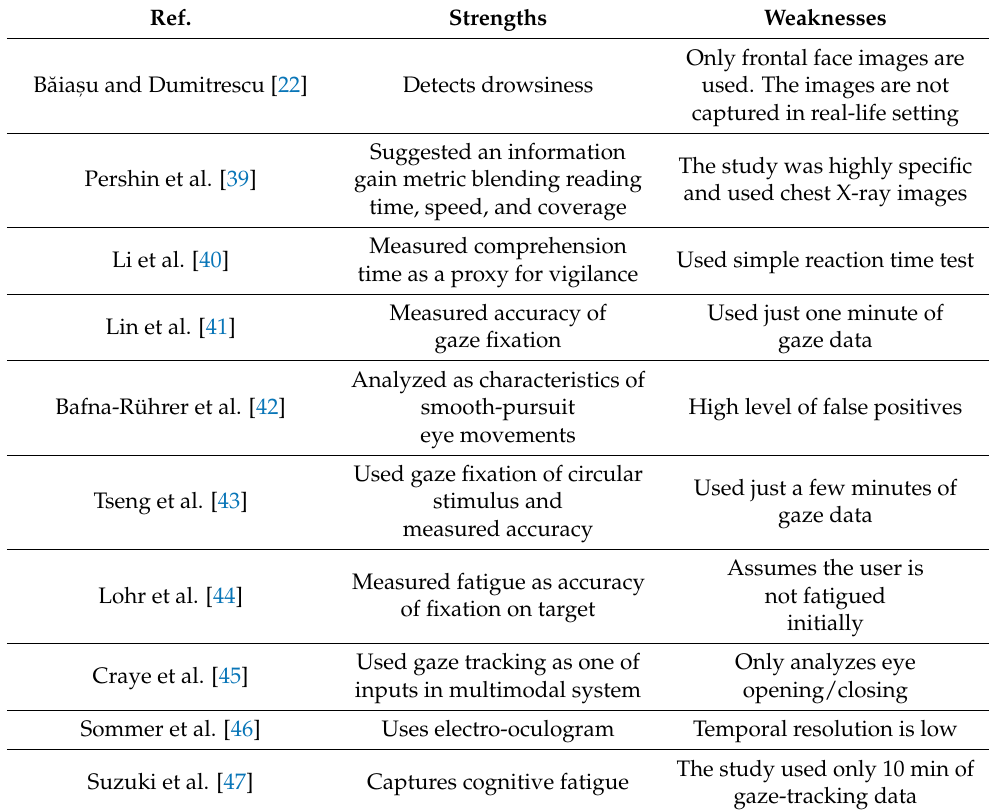
Only frontal face images are used. The images are